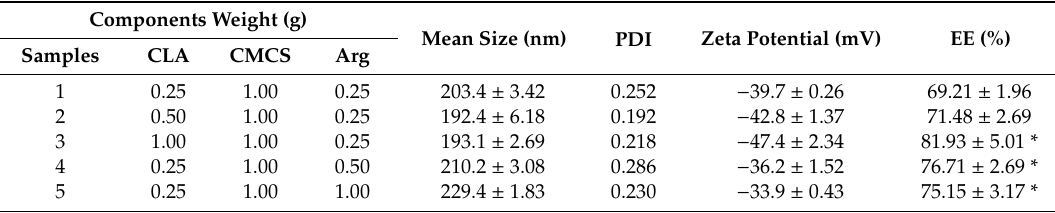
Table 1. General properties of CCA (1–5) conjugates in distilled water. Components Weight